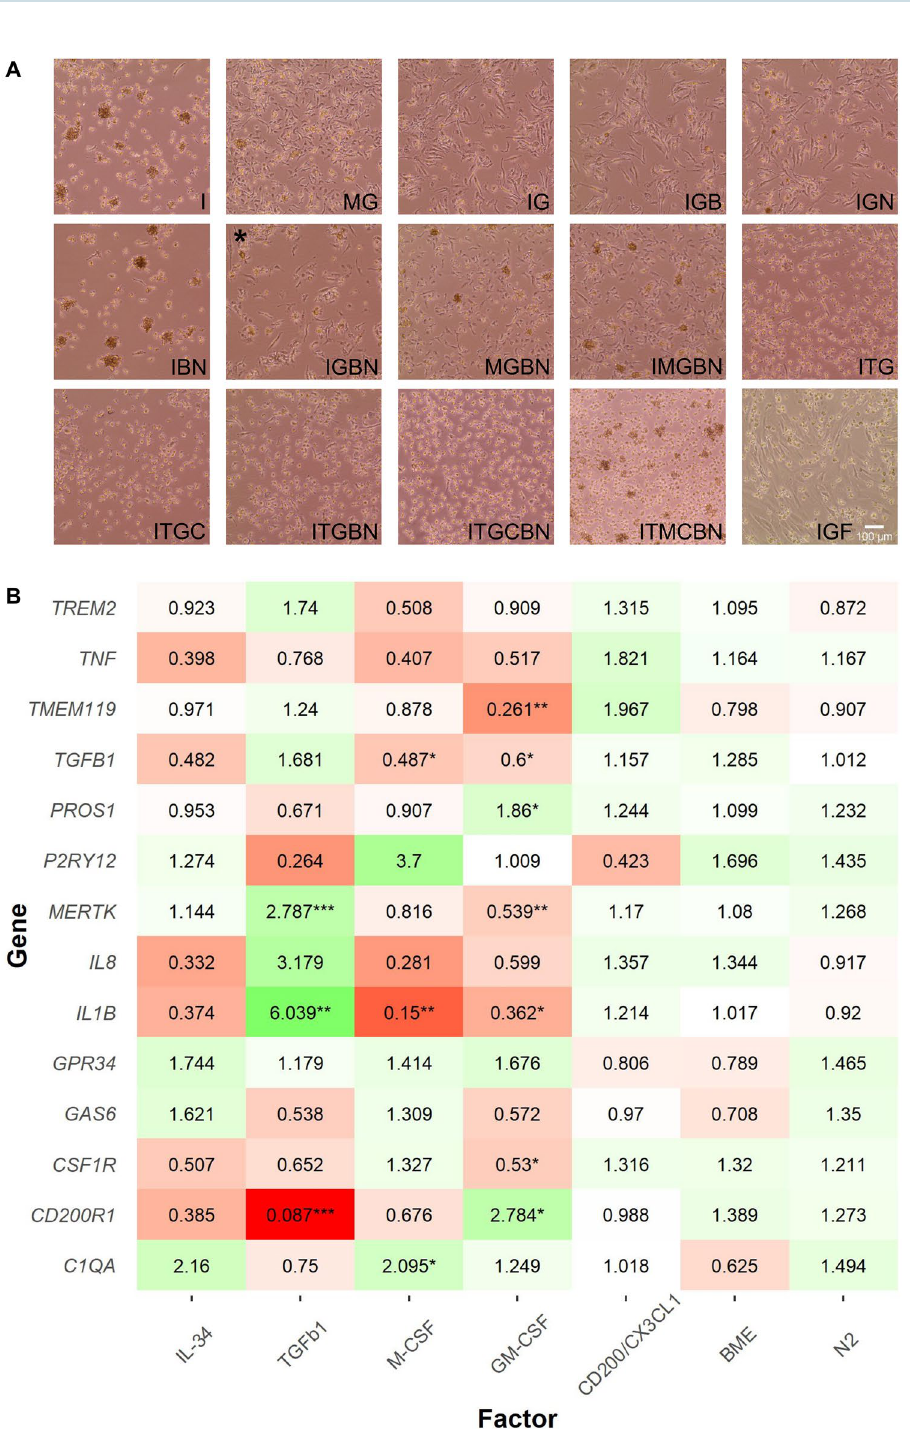
Figure 2. IL-34, TGF-β1, M-CSF, and GM-CSF affect iPSC-microglia morphology and result in transcriptional changes. ( A ) Morphology of microglia cultured for 14 days in 15 different media combinations on Geltrex. Each letter corresponds to a growth factor or compound; I IL-34, T TGF-β1, M M-CSF, G GM-CSF, C CX3CL1/CD200, B β-mercaptoethanol, N N-2 supplement, F Foetal Bovine Serum. Phase contrast images taken at ×10 magnification, scale bar 100 µm. * media IGBN is media published by Haenseler et al., and is the baseline for comparison. ( B ) qPCR results of known microglial marker genes in medium containing different growth factors. Fold changes initially calculated to IGBN before undertaking linear regression, regressing out each individual factor. TGF-β1, M-CSF, GM-CSF all result in transcriptional changes. CD200/CX3CL1, β-mercaptoethanol, and N-2 supplement result in no significant change in microglial gene expression. Fold changes are shown by colour, where green is increased expression and red is decreased and the number within cells. Stars indicate Bonferroni corrected significance, ***p < 0.001, **p < 0.01, *p < 0.05. Heatmap generated in R using the pheatmap